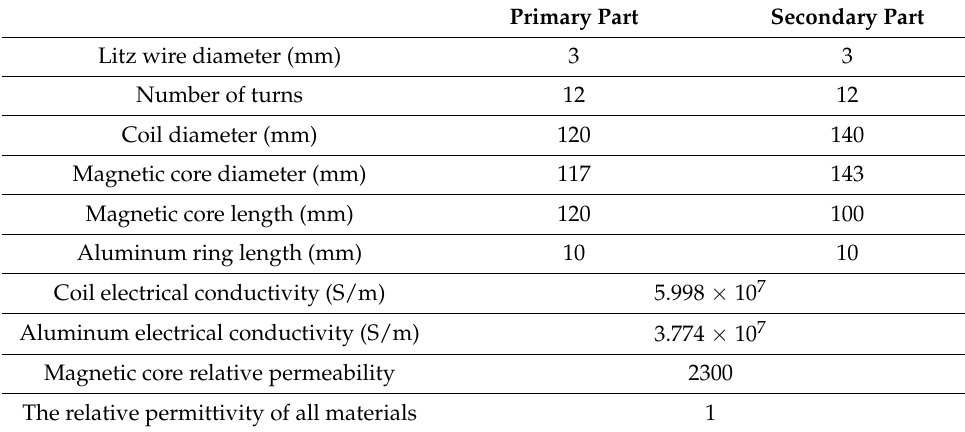
Table 1. Coupling mechanism